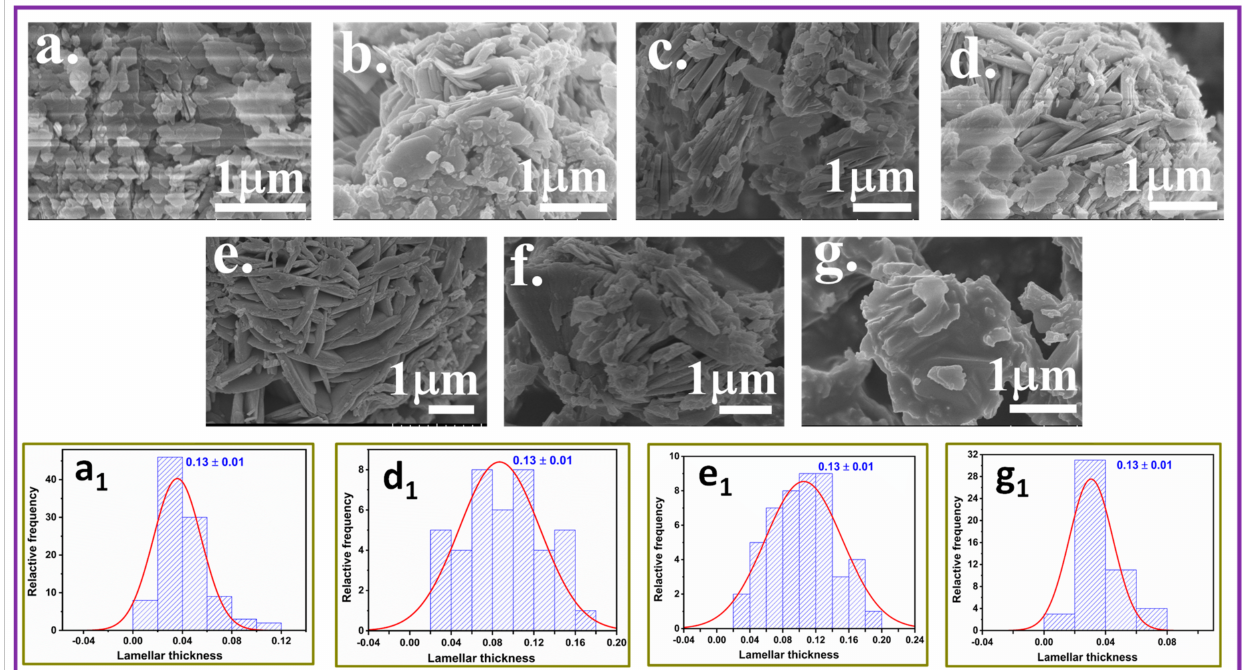
Figure 9. SEM imaging was obtained to observe the structural morphology of the unpromoted precursor (Blank-PVPO) ( a ), and promoted precursors prepared from DES-Nb ( b ), DES-Mo ( c ), DES-Zr ( d ), DES-Zr-Mo ( e ), DES-Zr-Nb ( f ), DES-Zr-Mo- Nb ( g ). The lamellar thickness of the unpromoted precursor (Blank-PVPO) ( a 1 ), and promoted precursors prepared from monometallic DES-Zr ( d 1 ), bi-metallic DES-Zr-Mo ( e 1 ), and trimetallic DES-Zr-Mo-Nb ( g 1 ).